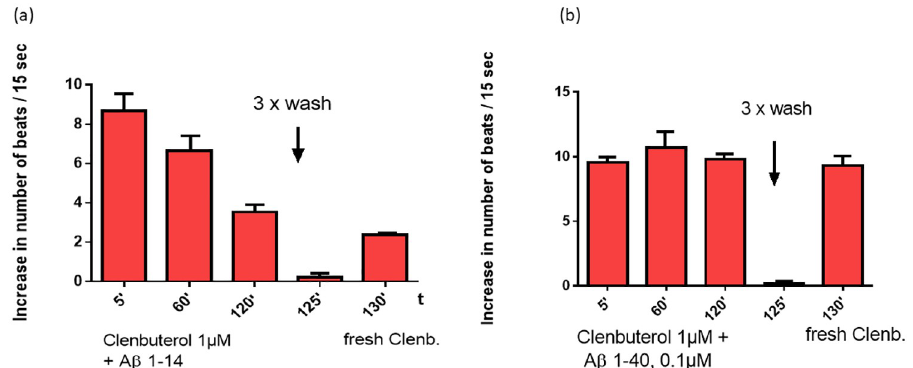
Fig 4. Influence of the A β peptides on the clenbuterol induced β 2-adrenoceptor desensitization: The desensitization of the β -AR response by clenbuterol, was not influenced by the short chain A β peptides (a). However, the long chain A β peptides A β 10–37, A β 1–40, and A β 1–42 prevent the desensitization and exert a permanent stimulation of the β 2-AR signal cascade (b).